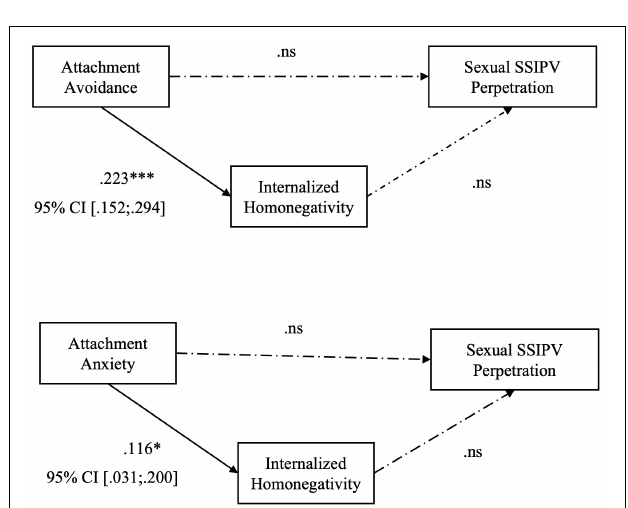
FIGURE 3 | Hp. 2 Path analysis with the score of perpetrated Psychological Aggression as the outcome; the total score of MISS as the mediator, and the score of anxiety and avoidance as the predictors. ∗ p < 0.05; ∗∗∗ p < 0.001.